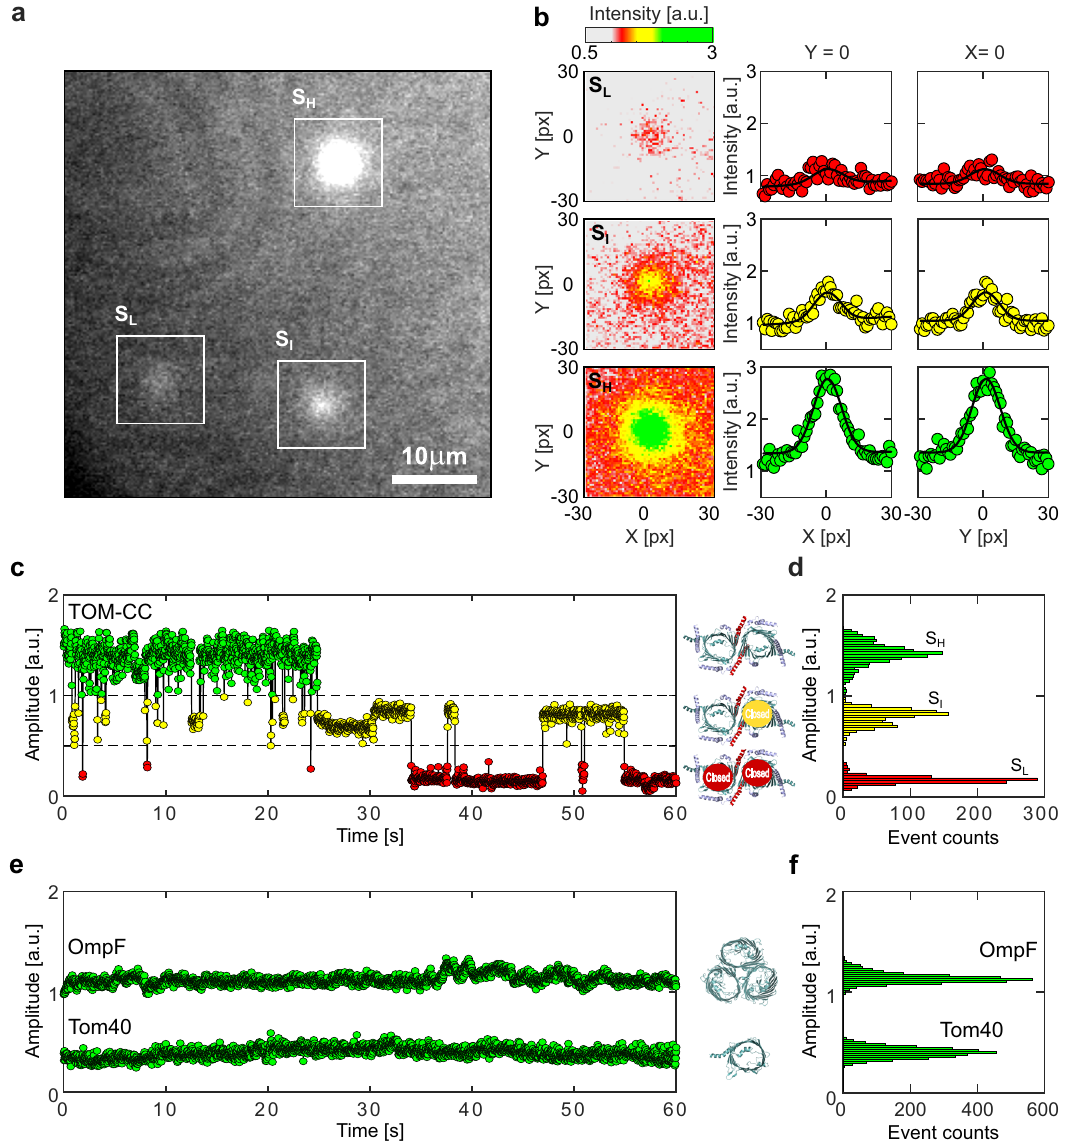
Fig. 2 Visualizing the two-pore channel activity of TOM-CC. a Typical image ( N > 5.3 × 10 5 ) of a non-modi fi ed agarose-supported DIB membrane with TOM-CC channels under 488 nm TIRF-illumination. The white squares mark spots of high (S H ), intermediate (S I ), and low (S L ) intensity (Supplementary Movie S1). The TIRF image has not been corrected by fl uorescence bleaching or by a fi lter algorithm. b Fitting the fl uorescence intensity pro fi le of the three spots marked in ( a ) to two-dimensional Gaussian functions (Supplementary Movie S2). Red, yellow and green intensity pro fi les represent TOM-CC in S L , S I , and S H demonstrating Tom40 channels, which are fully closed, one and two channels open, respectively. Pixel size, 0.16 μ m. c Fluorescence amplitude trace and ( d ) amplitude histogram of the two-pore β -barrel protein channel TOM-CC. The TOM-CC channel switches between S H , S I , and S L permeability states over time. Inserts, schematic of N. crassa TOM core complex with two pores open in S H (top), one pore open in S I (middle), and two pores closed in S L (bottom) (EMDB, EMD-3761 6 ); e Representative single-channel optical recordings and ( f ) amplitude histograms of the TOM-CC subunit Tom40 and OmpF. Tom40 and OmpF are completely embedded in the lipid bilayer. In contrast to the two-pore β -barrel protein complex TOM-CC, Tom40, and OmpF exhibit one permeability state over time only. Insert, structural model of N. crassa Tom40 (EMDB, EMD-3761) and E. coli OmpF (PDB, 1OPF) with open β -barrel pores. Data were acquired as described in Fig. 1c at a frame rate of 47.5 s − 1 . a.u. arbitrary